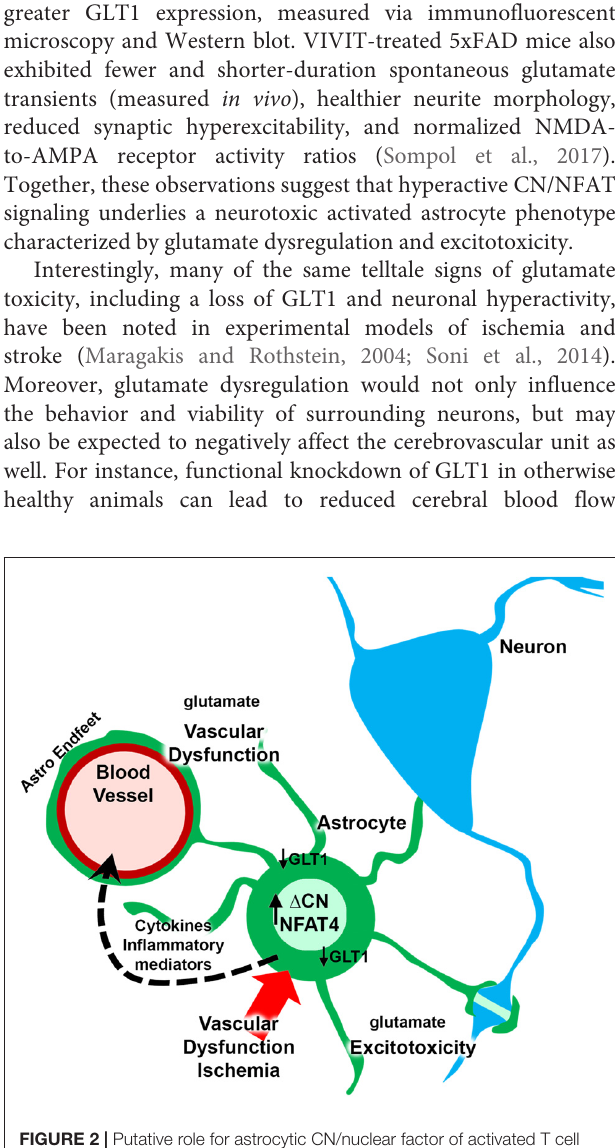
FIGURE 2 | Putative role for astrocytic CN/nuclear factor of activated T cell (NFAT) in vascular dysfunction and neurodegeneration. Ischemia arising from vascular degeneration or disruption leads to increased expression of ∆ CN and hyperactivation of NFAT4 in astrocytes. The CN/NFAT pathway induces numerous cytokines and other inflammatory mediators linked to neuroinflammation. Some of these factors may target blood vessels, leading to perivascular inflammation. CN/NFAT signaling also leads to the downregulation of GLT1 glutamate transporters resulting in elevated extracellular glutamate levels. Glutamate causes excitotoxicity at synaptic connections and disrupts astrocyte endfeet and/or blood brain barrier (BBB) integrity, leading to further vascular dysfunction and/or